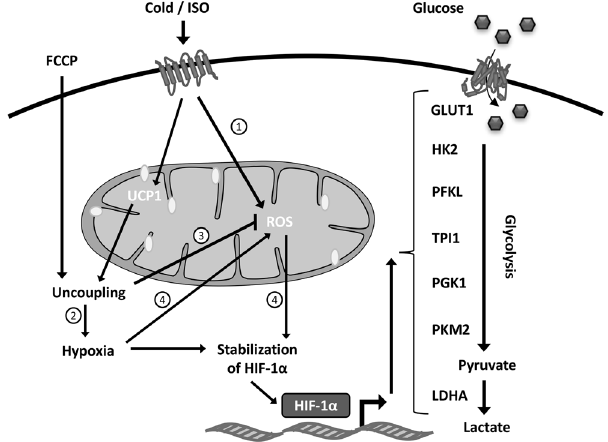
Figure 8. A proposed model for HIF-1 α -dependent regulation of glycolysis in brown adipocytes. Illustrated is a model of how cold and β -adrenergic stimulation cause HIF-1 α stabilization in brown adipocytes through mitochondrial uncoupling and reactive oxygen species (ROS) production. HIF-1 α in turn induces the expression of Glut1, Hk2, Pfkl, Tpi1, Pgk1, Pkm2 and Ldha , increasing glycolytic flux capacity. 1 ) β -Adrenergic stimulation induces the production of mitochondrial ROS in brown adipocytes 24 . 2 ) Cold-stimulated mitochondrial uncoupling induces hypoxia in BAT 41 . 3 ) FCCP-induced mitochondrial uncoupling decreases mitochondrial ROS production in brown adipocytes 42, 43 . 4 ) Hypoxia-induced HIF-1 α stabilization through increased mitochondrial ROS production 25